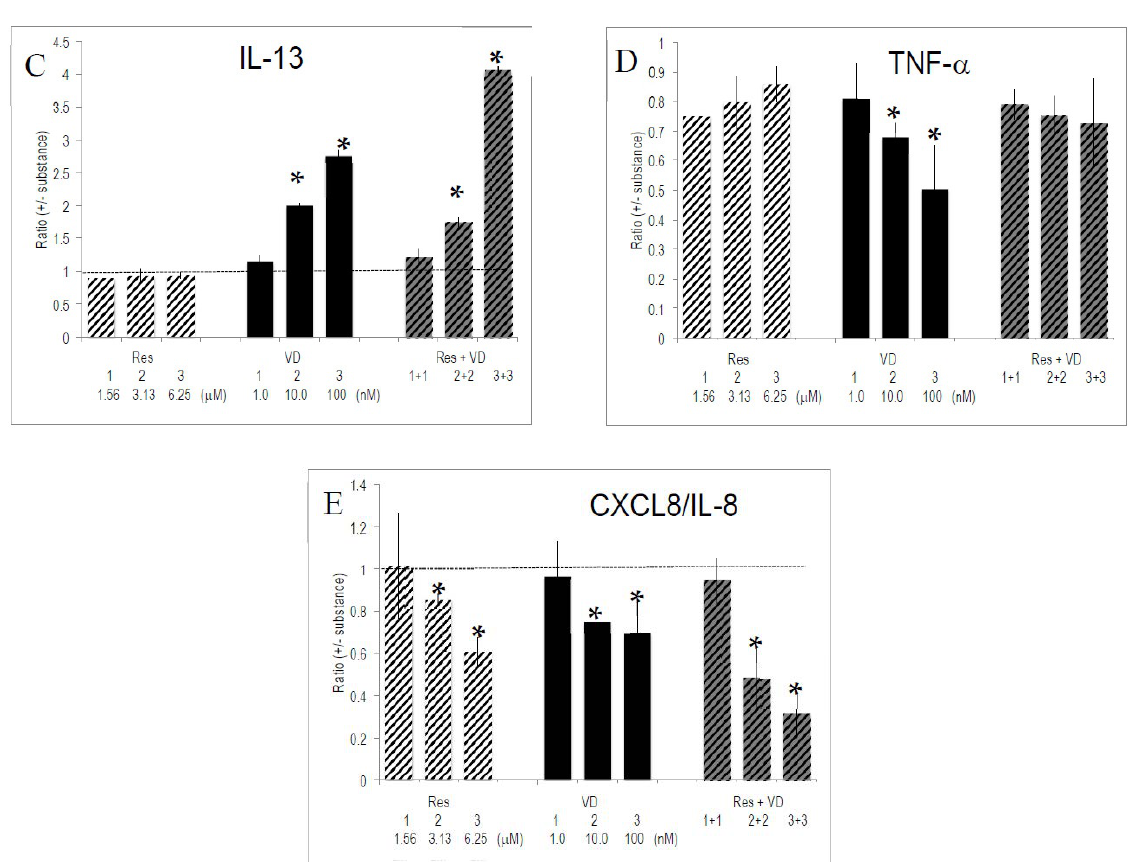
Figure 3. Effect of combinations of substances on cytokine/interleukin production. Anti-CD3/CD28 activated PBMCs were cultured for 4 days (see: reference added in proof) with the indicated substances and combinations thereof. Gene expression was quantified by PCR and the ratio of expression (+/ − substances) was computed as described in Materials and Methods. Bars indicate SEM ( n = 4 experiments with donors of PBMCs, each done in triplicate cultures). * indicate p values <0.05 versus anti-CD3/CD28 stimulated PBMCs. ( A – E ) refers to the ratio of secreted IL-2, INF- γ , IL-13, TNF- α and CXCL8/IL-8, respectively.